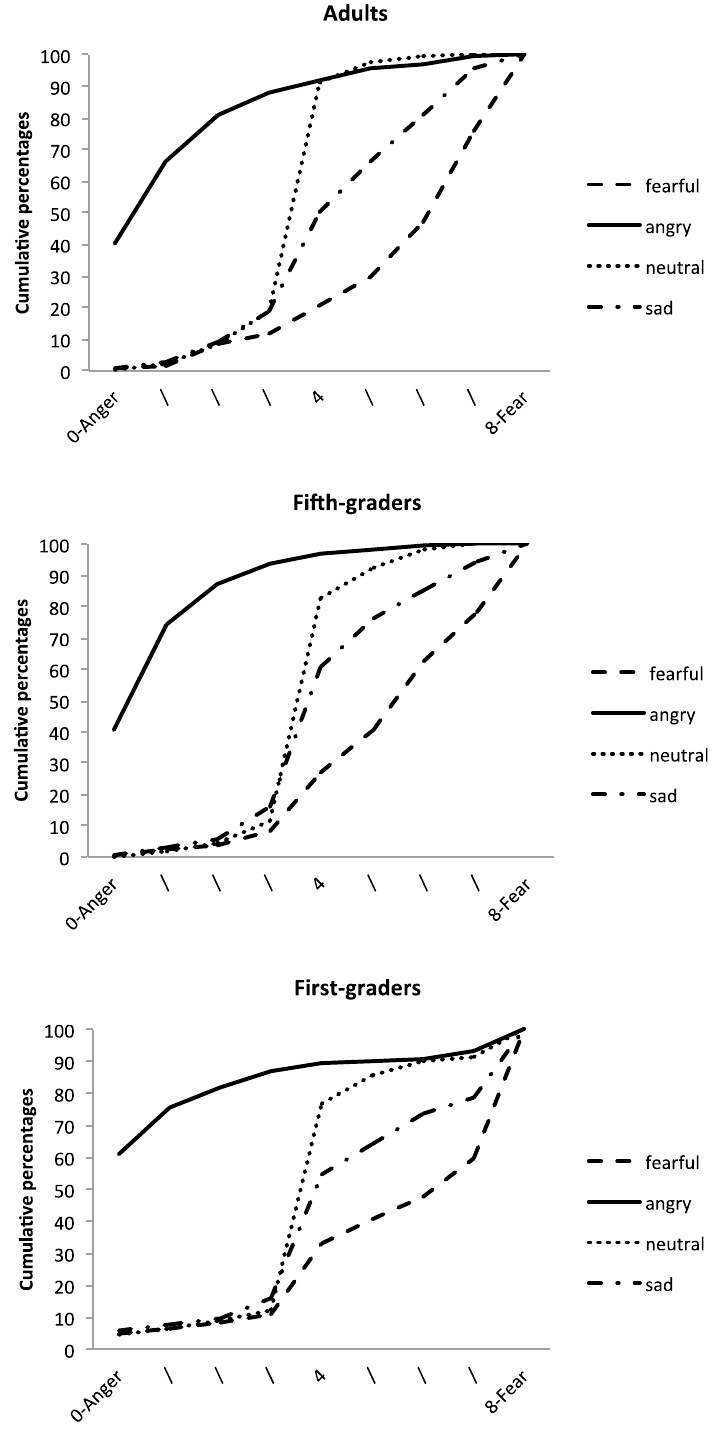
Figure 2. Cumulative percentages of the perception of EFE on Scale 1, for each age